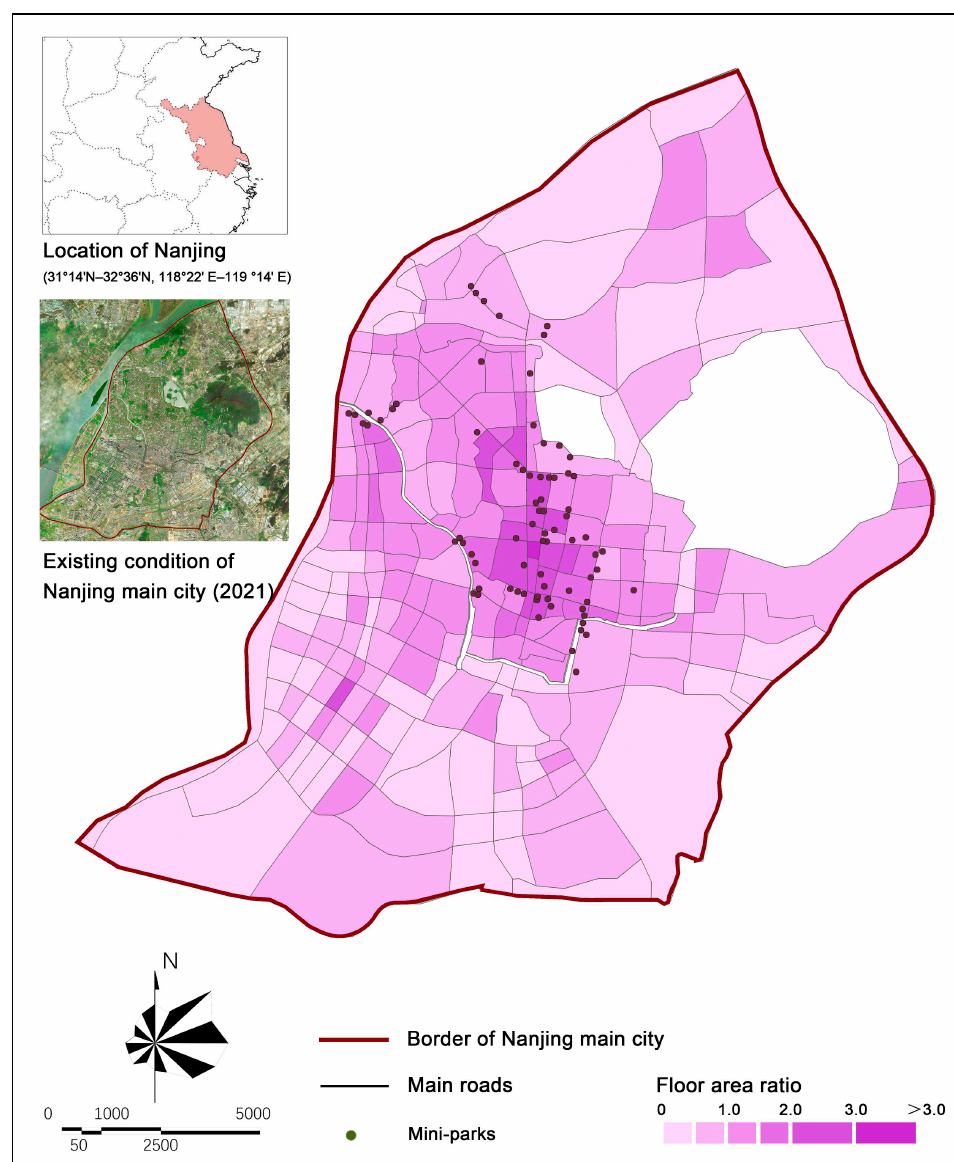
Figure 1. Study area and distribution of pocket park